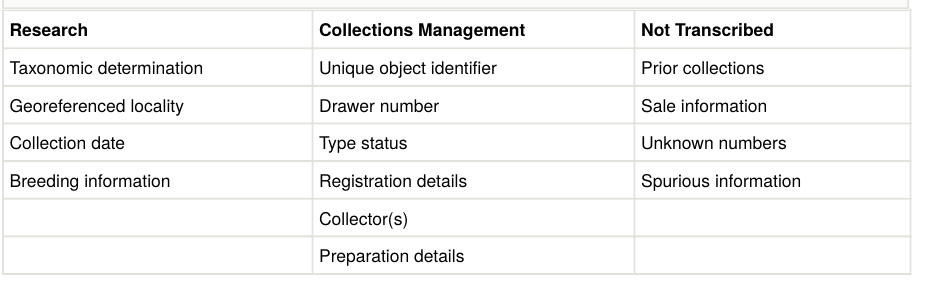
Table 4. Data transcribed from collection